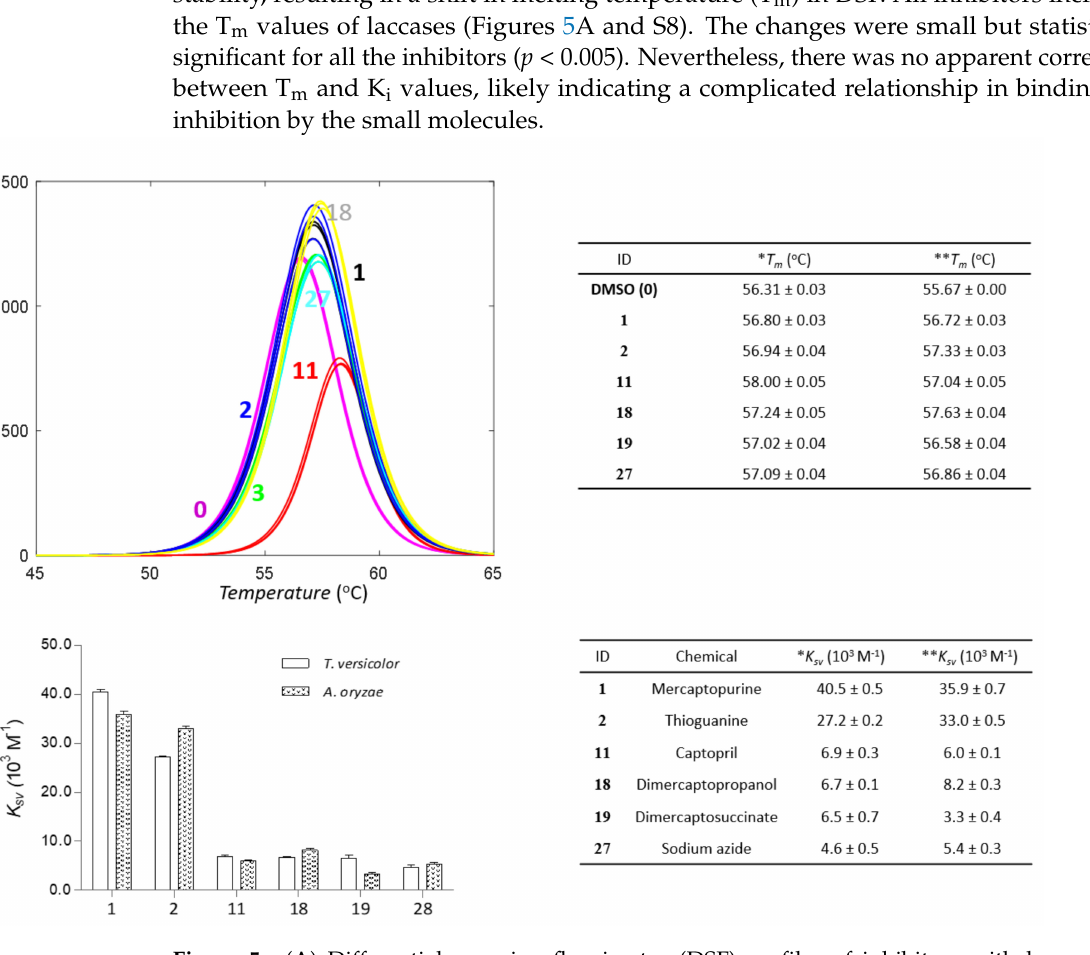
Figure 5. ( A ) Differential scanning fluorimetry (DSF) profiles of inhibitors with laccase from T. versicolor . DSF profiles for 0 (DMSO), 1 (mercaptopurine), 2 ( thioguanine), 11 (captopril), 18 ( mercaptopropanol), 19 (dimercaptosuccinate), and 27 (sodium azide), respectively. ( B ) Stern– Volmer constants obtained from the slope of the Stern–Volmer plot in fluorescence-quenching experiments are drawn and represented. * and ** represent laccase from T. versicolor and A. oryzae ,